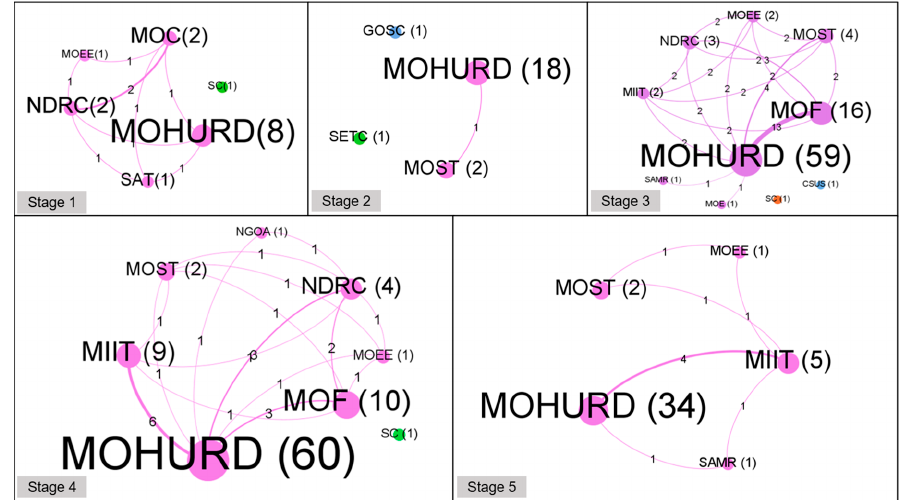
Figure 7. Co-author networks of GB policymaking agencies in five